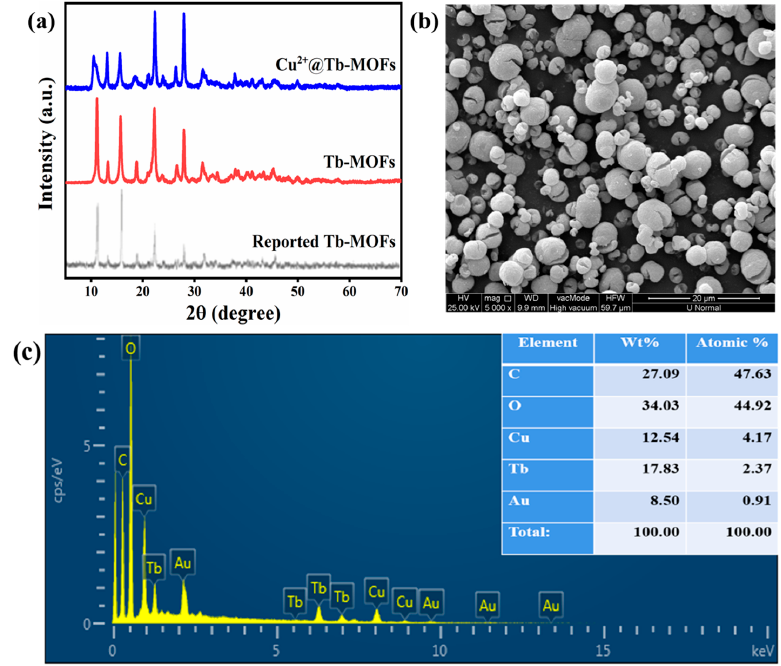
Figure 1. ( a ) PXRD patterns of the reported Tb-MOFs, the synthetic crystalline Tb-MOFs and Cu 2+ @Tb-MOFs samples; ( b ) SEM image and ( c ) EDX of Cu 2+ @Tb-MOFs samples. Cu 2+ @Tb-MOFs samples; ( b ) SEM image and ( c ) EDX of Cu 2+ @Tb-MOFs Morphology of Cu 2+ @Tb-MOFs was studied by scanning electron micrograph (SEM).